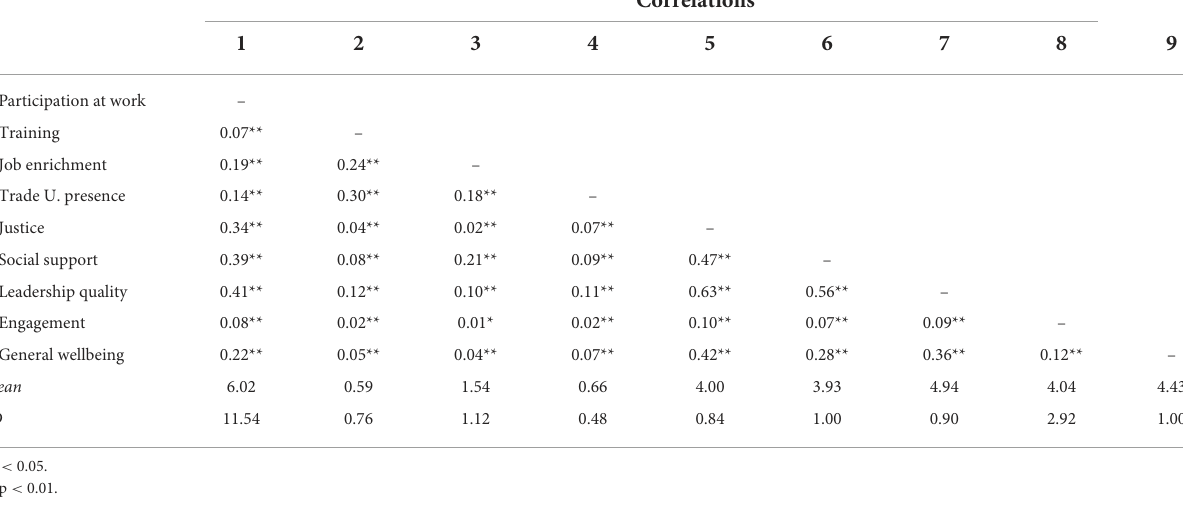
TABLE 2 Model fit statistics.